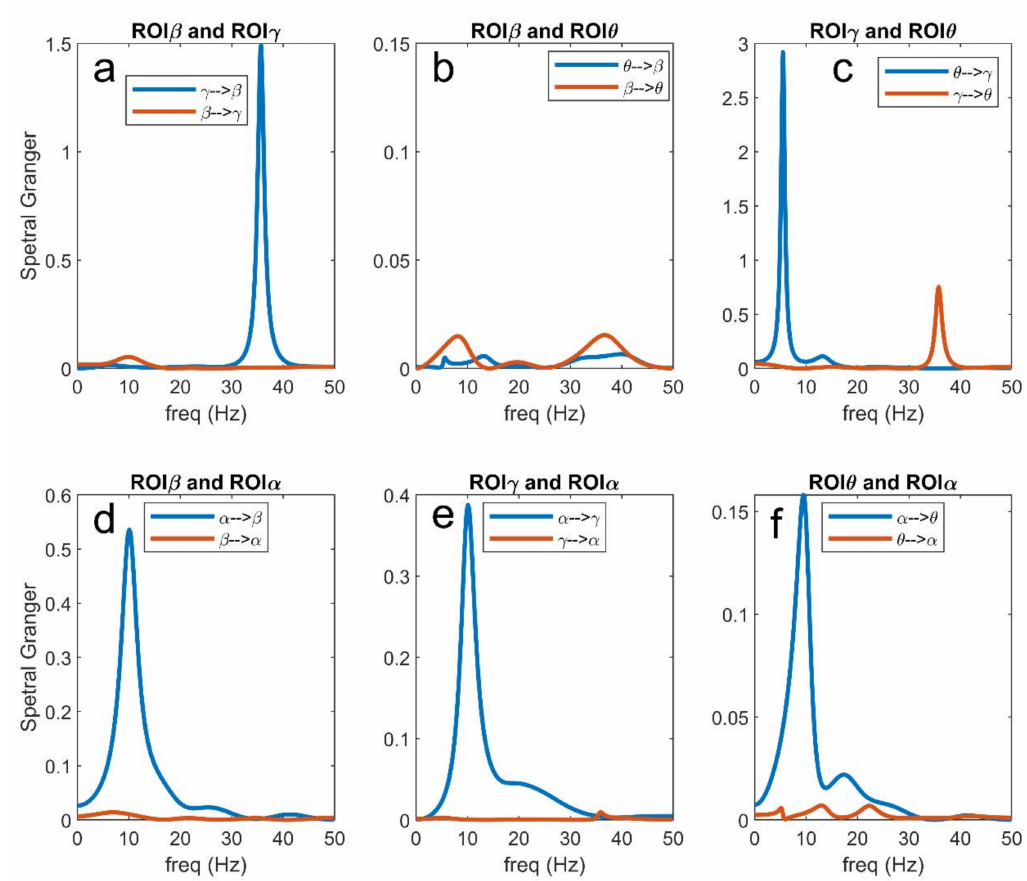
Figure 12. Values of connectivity among the ROIs estimated with the spectral Granger causality, with reference to the network in Figure 2A but with the input to ROI β reduced from 400 down to 100. The values are plotted as a function of frequency (note the use of different y -axes to emphasize the different cases). From the comparison of these panels with those in Figure 11 emerges that: the absence of α rhythm transmitted from ROI β to ROI γ is evident ( a ); the coupling between ROI θ and ROI β is negligible ( b ); the transmission γ → θ is significantly reduced, while that θ → γ is increased ( c ); the α rhythm transmission from ROI α to ROI β ( d ) and from ROI α to ROI γ is increased ( e ); while the α rhythm transmission from ROI α to ROI θ ( f ) is